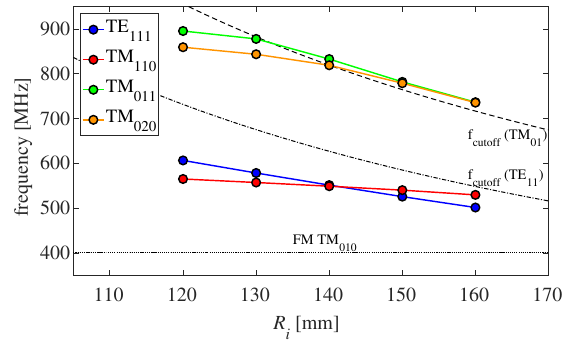
FIG. 2. The dependency of the frequency of the TE 111 , TM 110 , TM 011 and TM 020 modes on R i . For each case, the frequency of the FM, i.e., the TM 010 mode is tuned to 400.79 MHz by varying R eq . The parameter sweep is carried out around the geometric parameters taken from [17]. An aperture radius R i approximately above 145 mm helps to untrap the dangerous monopole HOMs. Note that the cavity in [17] is optimized such that the frequencies of the TE 111 and TM 110 modes are almost